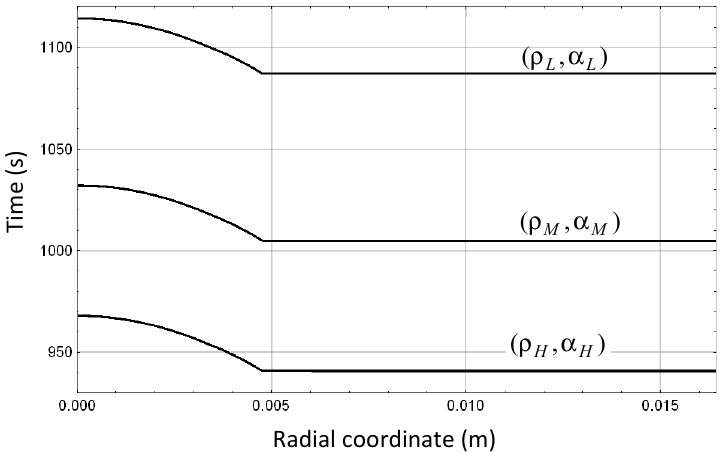
ρα . ρα and ),( ρα , ),( LL MM HH